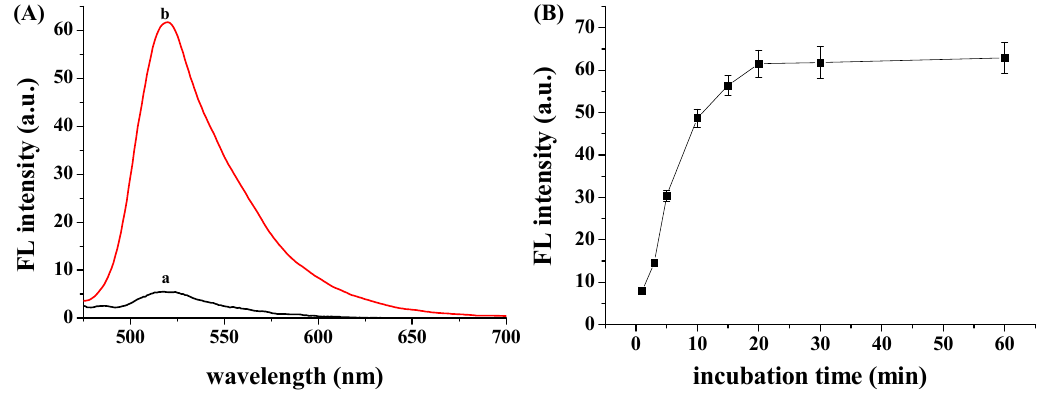
Figure 3. ( A ) Fluorescence spectra of FITC-PPLRINRHILTR/GO in the absence (curve a) and presence (curve b) of hCG. The concentrations of FITC-PPLRINRHILTR and hCG were 50 nM and 50 IU/mL, respectively; ( B ) Fluorescence restoration of FITC-PPLRINRHILTR/GO by hCG as a function of time.